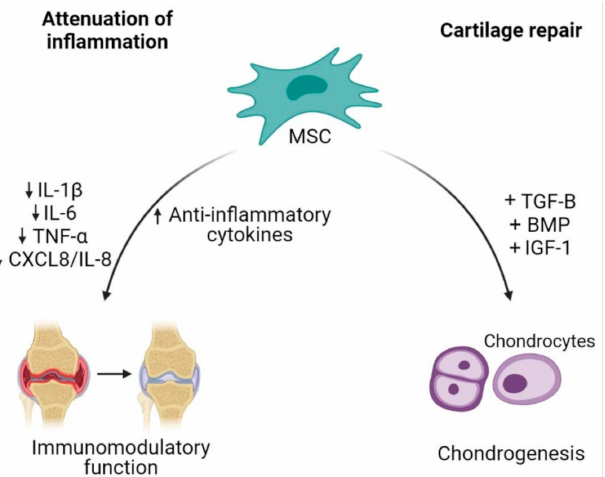
Figure 2. Mesenchymal stem cells (MSCs) as an alternative cell-based therapy for osteoarthritis. Mesenchymal stem cells dampen inflammatory activities in OA by reducing the releases of pro- inflammatory cytokines and increasing anti-inflammatory cytokines. Additionally, their plasticity characteristic allows differentiation of MSCs into chondrocytes, thus contributing to cartilage